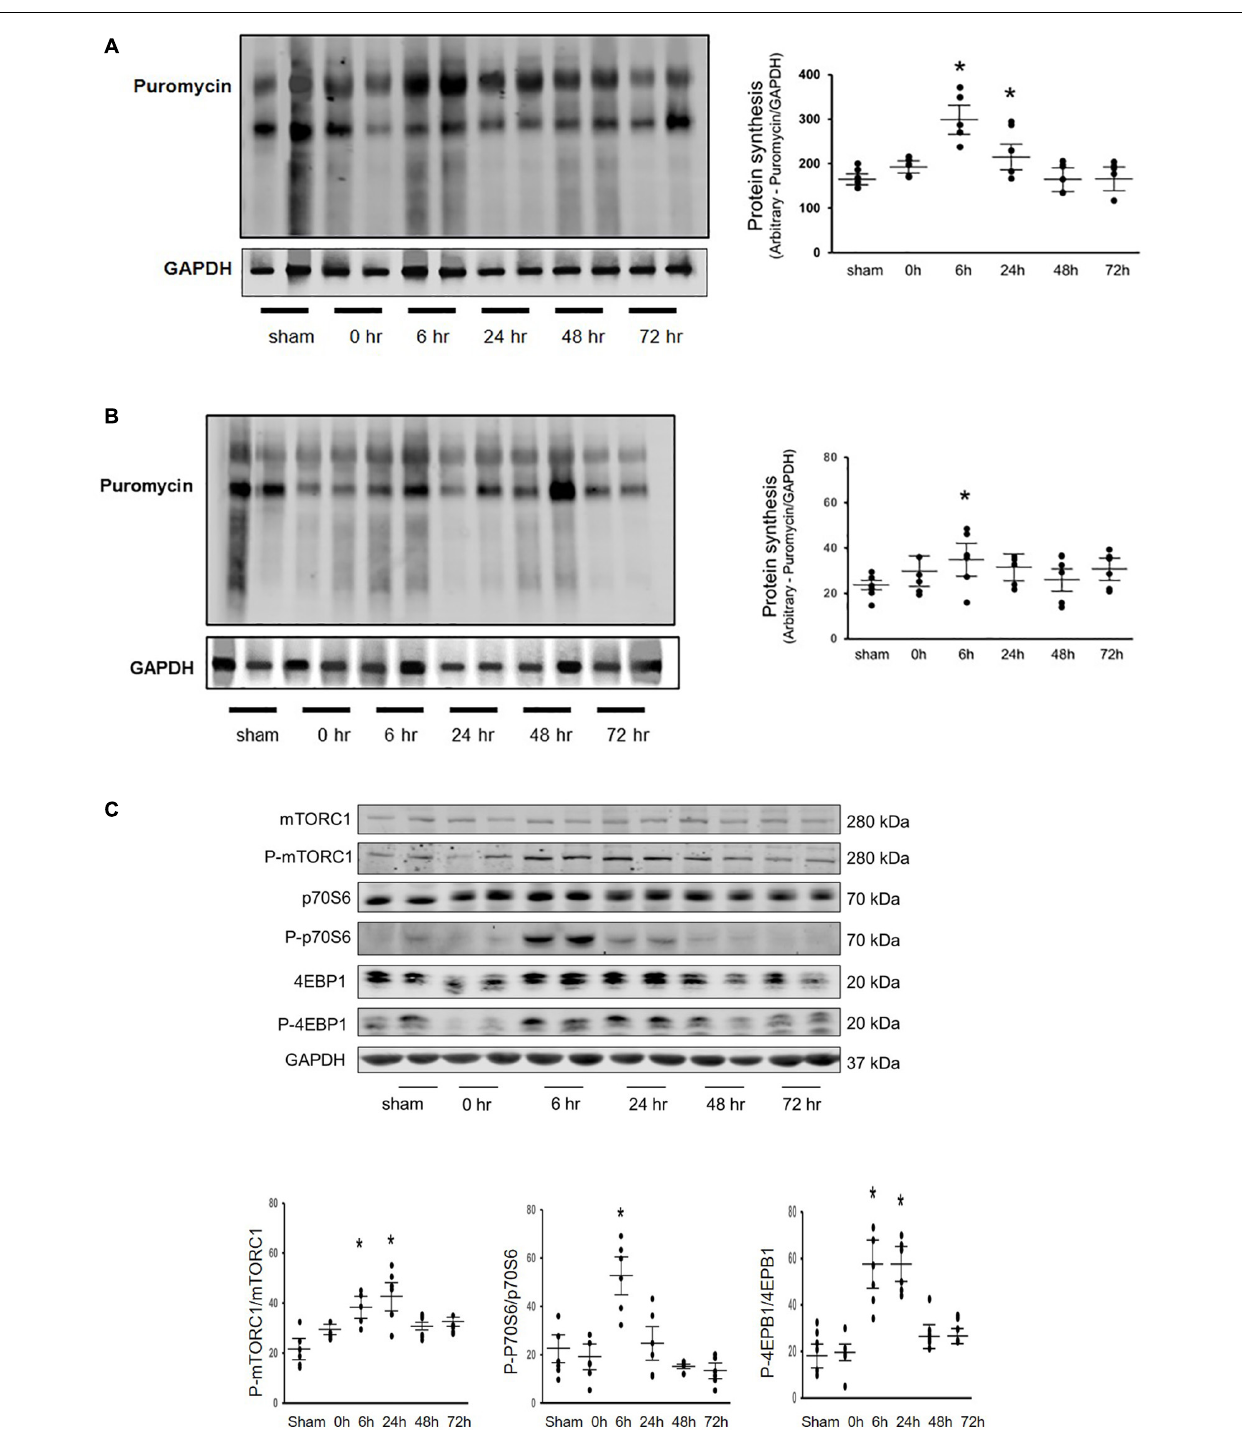
FIGURE 3 | Blocking exosome secretion limited the Acu/LFES-induced increase in protein synthesis. Experiments were performed in the sham and Acu/LFES treated mice. GW4869 was injected 16 h before Acu/LFES and puromycin was injected 30 min before harvest. Protein was isolated from the muscle of mice immediately (0), 6–, 24, 48 and 72 h after Acu/LFES. Puromycin in tissue lysates was measured by Western blots. The point graph of incorporate puromycin into gastrocnemius muscle (A) and triceps brachii muscle (B) show the change of the density of puromycin protein normalized to their corresponding GAPDH protein ( n = 6/group; * p < 0.05 vs. sham). The proteins mTORC1, 4EBP1 and P70S6 were measured by Western blotting in gastrocnemius muscle (C) of sham and Acu/LFES mice. The bottom point graphs show the ration of phosphate protein to total protein normalized to the same sample GAPDH. Data is provided in arbitrary units ( n = 6/group; * p < 0.05 vs.